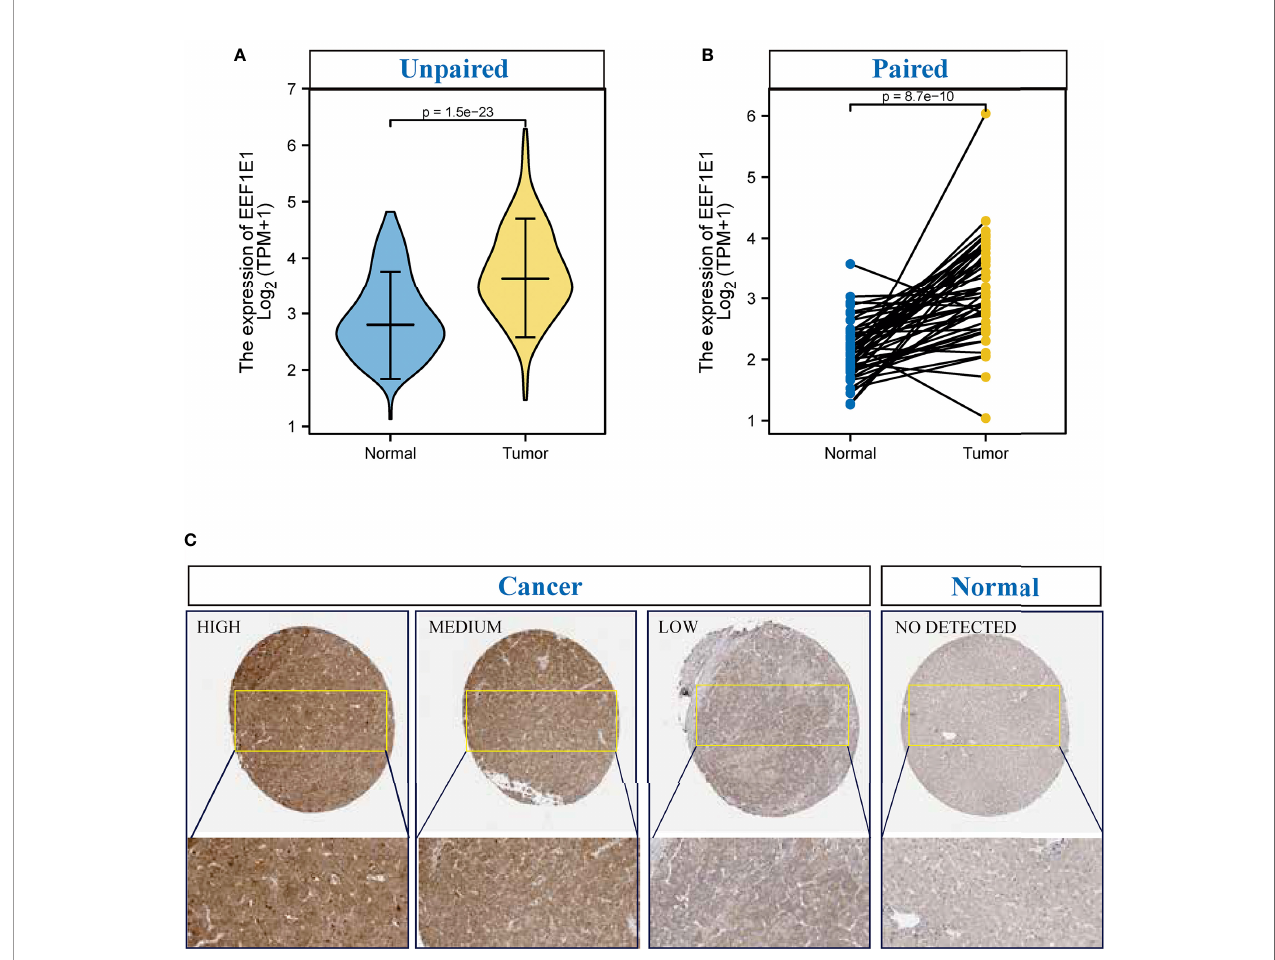
FIGURE 1 | The expression of EEF1E1 in HCC. (A) Comparing the expression of EEF1E1 in cancer and normal. (B) Comparing the expression of EEF1E1 in cancer and paracancerous. (C) The expression of EEF1E1 in HCC from Human protein